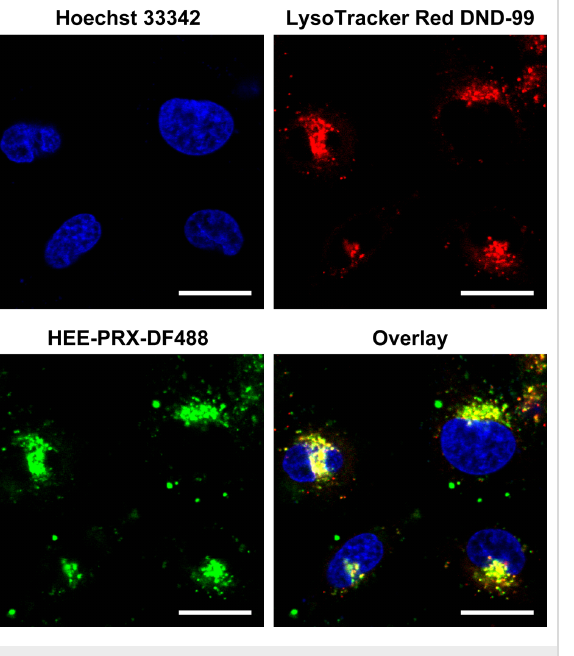
Figure 5: CLSM images of HeLa cells treated with HEE-PRX-DF488 ( 7 ) (500 μ g/mL) for 26 h (scale bars: 20 μ m). The acidic endosomes/ lysosomes and nuclei are stained with LysoTracker Red DND-99 and Hoechst 33342,